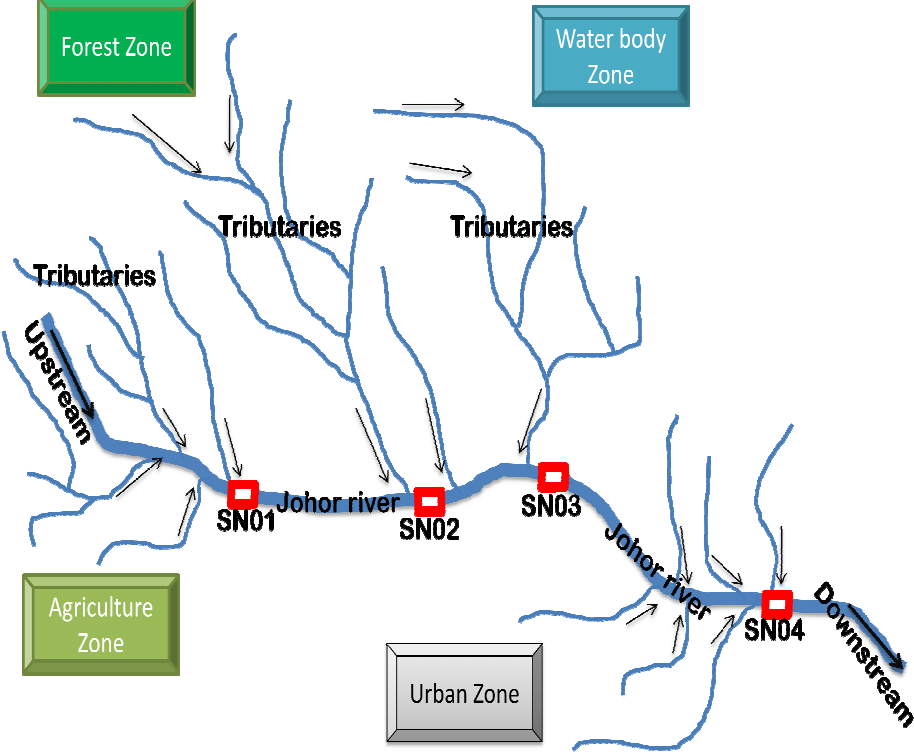
Fig. 1b. Schematic diagram of the main stream and tributaries and the key stations that used in prediction of water quality parameters. Fig. 1b: Schematic diagram Schematic diagram of the main stream and tributaries and the key that used in used in prediction of water quality parameters